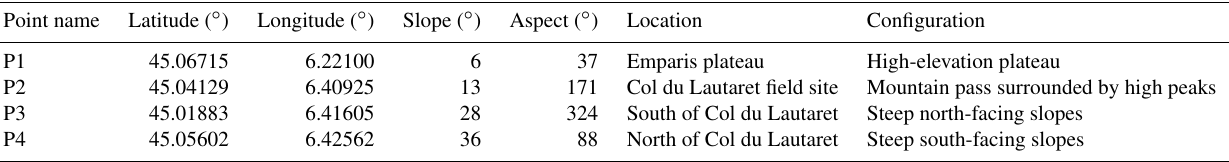
Table 2. Summary of the four selected pixels across the study site. Note that aspect is measured clockwise, with 0 ◦ representing the